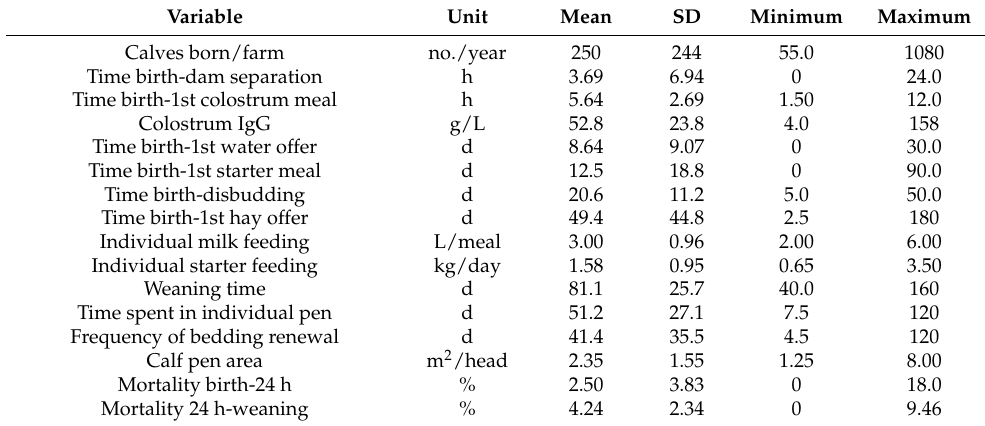
Table 1. Calf management practices and mortality during the preweaning period ( n =